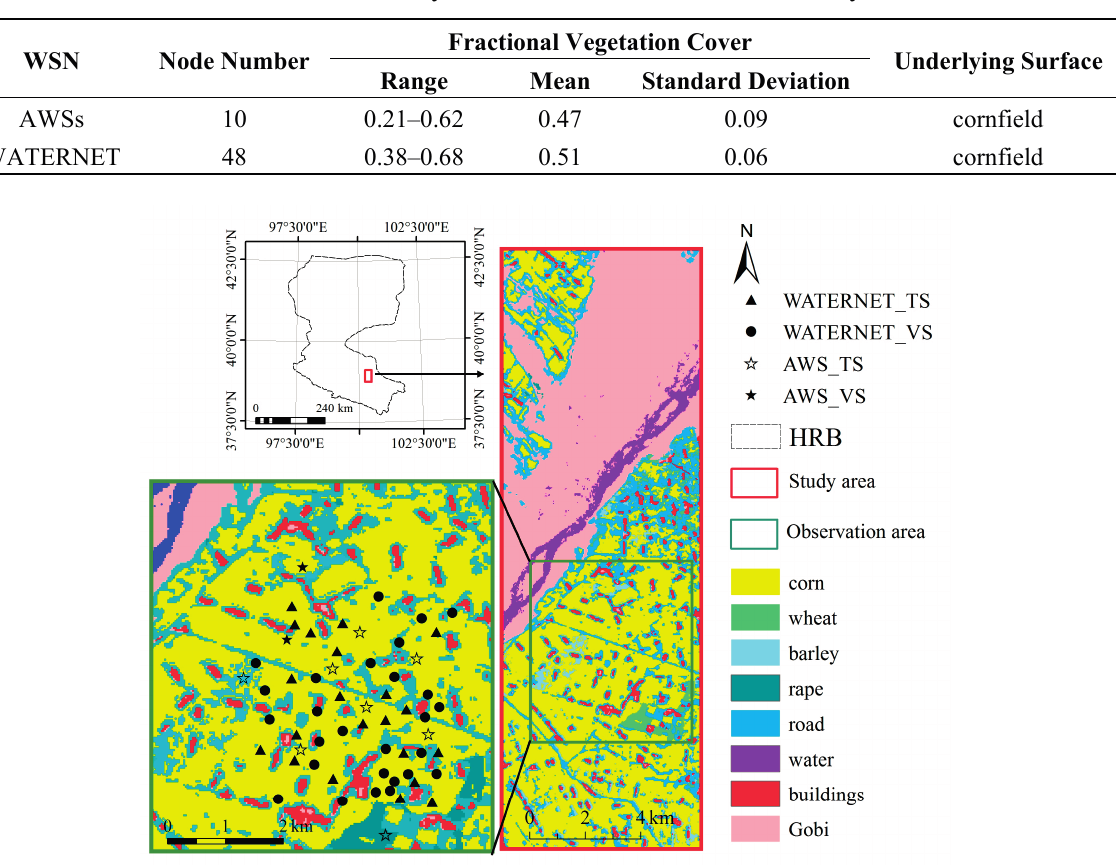
Table 1. Summary of the WSN data used in the study.